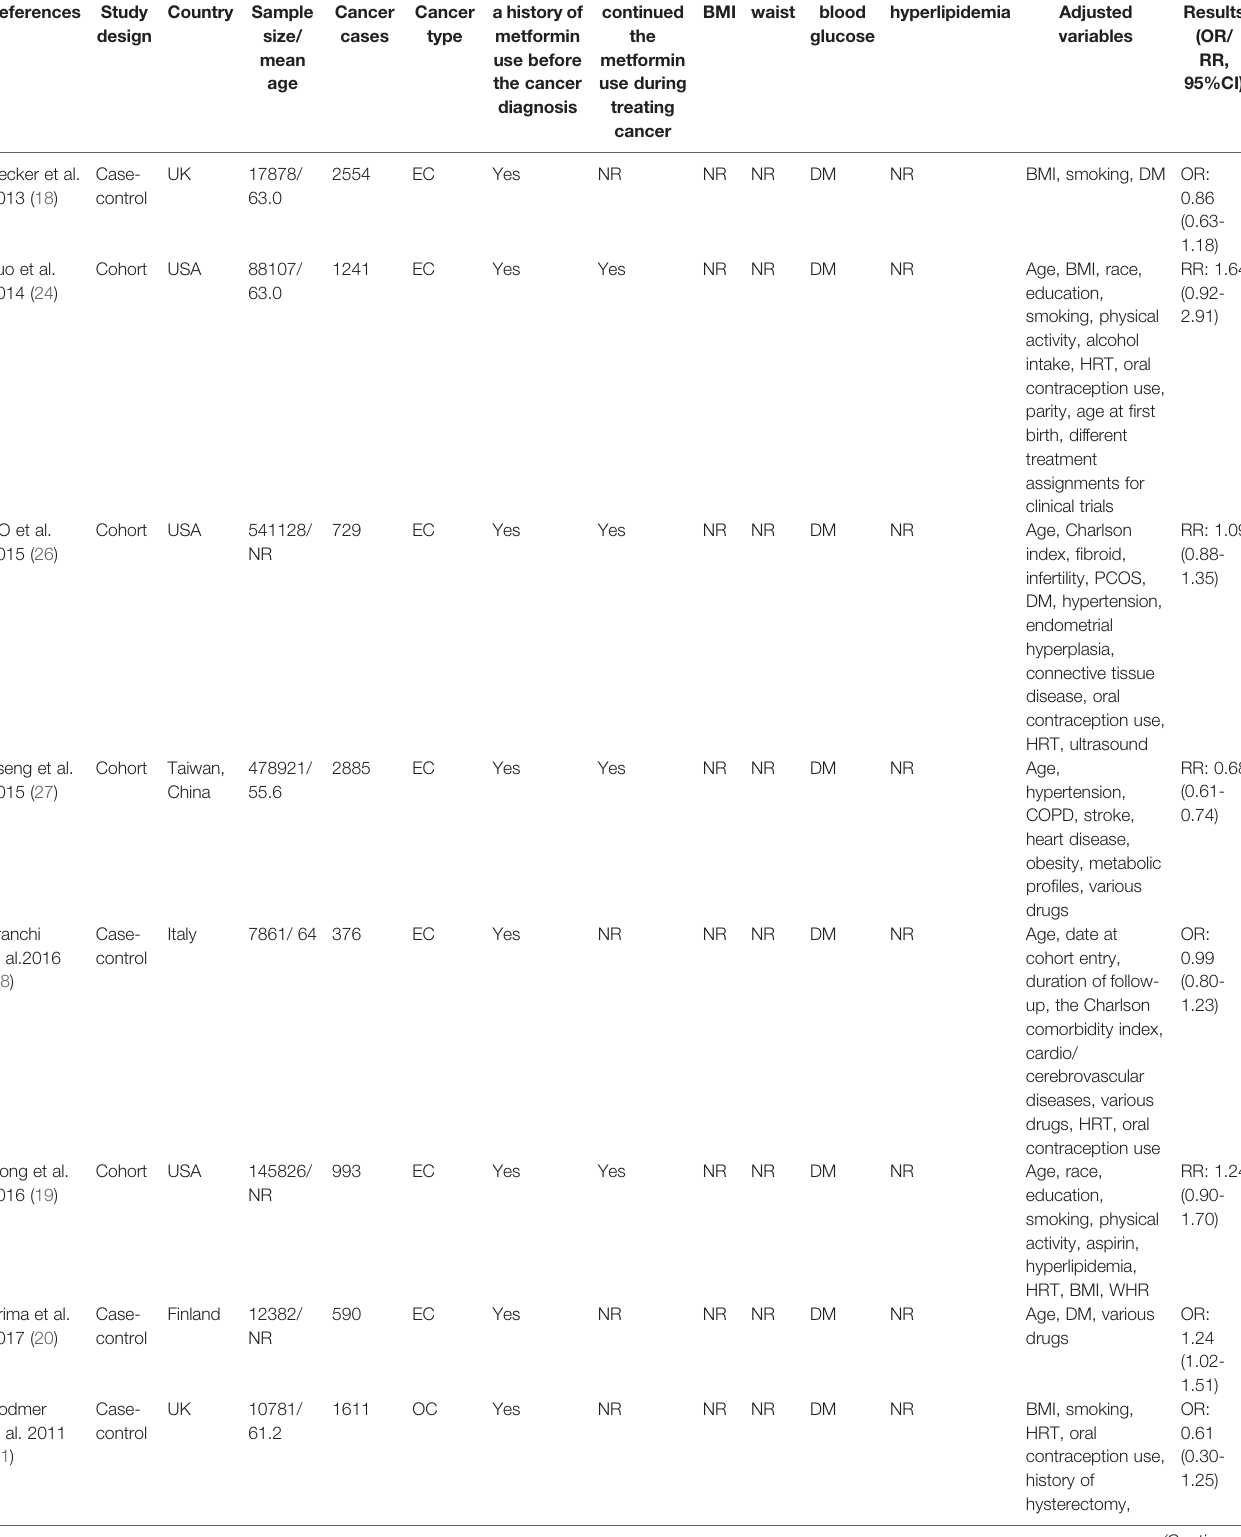
TABLE 1 | Characteristics of all included studies regarding association between metformin use and risk of gynecologic